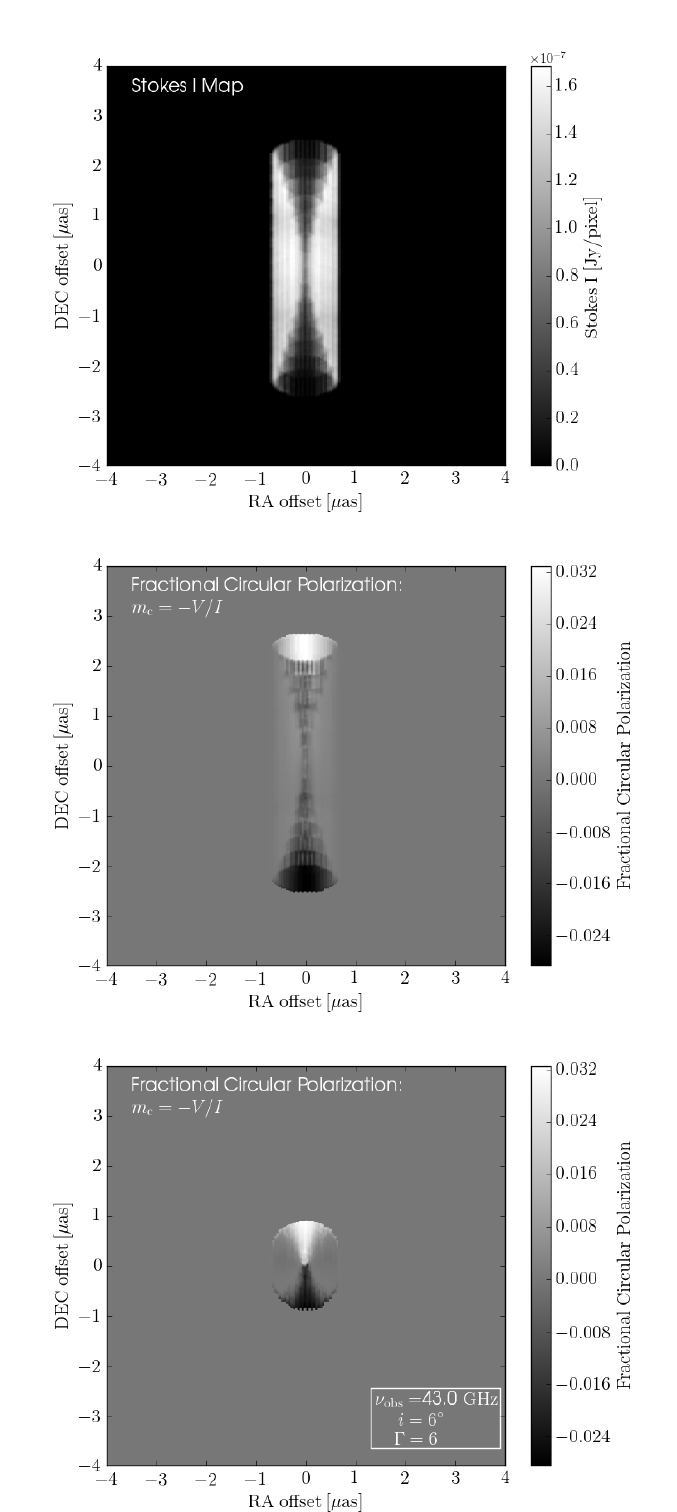
Figure 3. ( Upper panel )—A rendering of the total intensity (Stokes I ) in the co-moving frame highlighting the structure of the TEMZ computational grid; ( Middle panel )—A plot of the fractional circular polarization in the co-moving frame highlighting the different regions within the jet that produce positive/negative circular polarization; ( Lower panel )—A plot of the fractional circular polarization (in the observer’s frame) at an observing frequency of 43